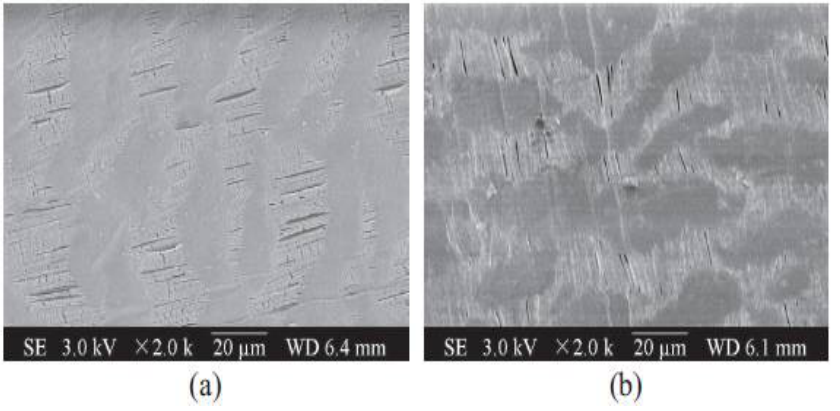
Figure 27. The morphological image of the PTFE membrane after the HA solution concentration experiment: ( a ) without ultrasonic irradiation; ( b ) with ultrasonic irradiation [139].